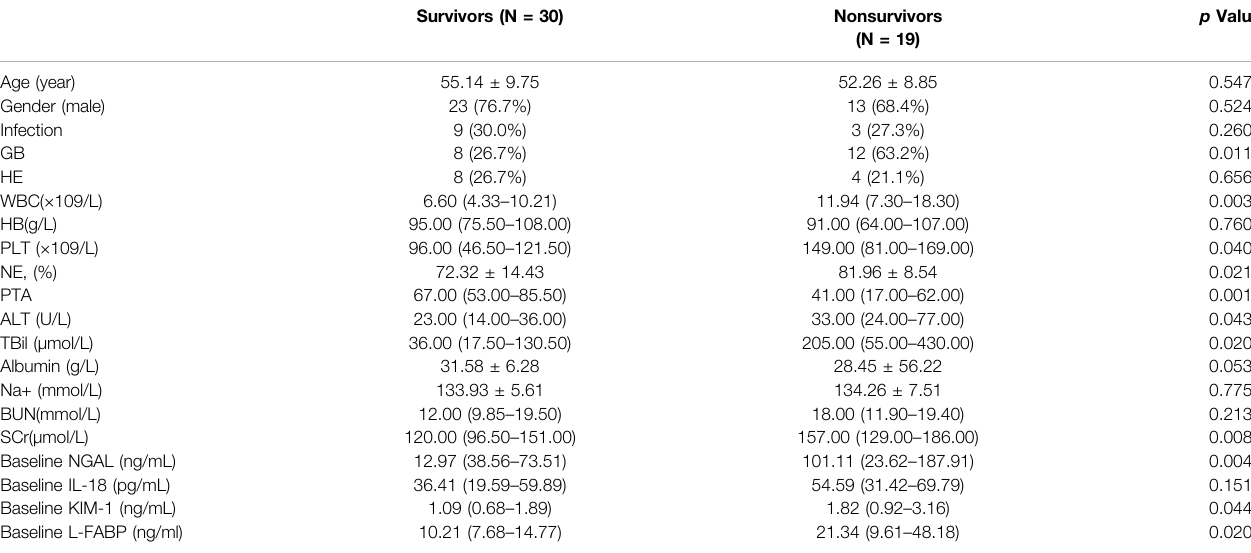
TABLE 5 | Characteristics of patients categorized according to transplant-free survival at 28